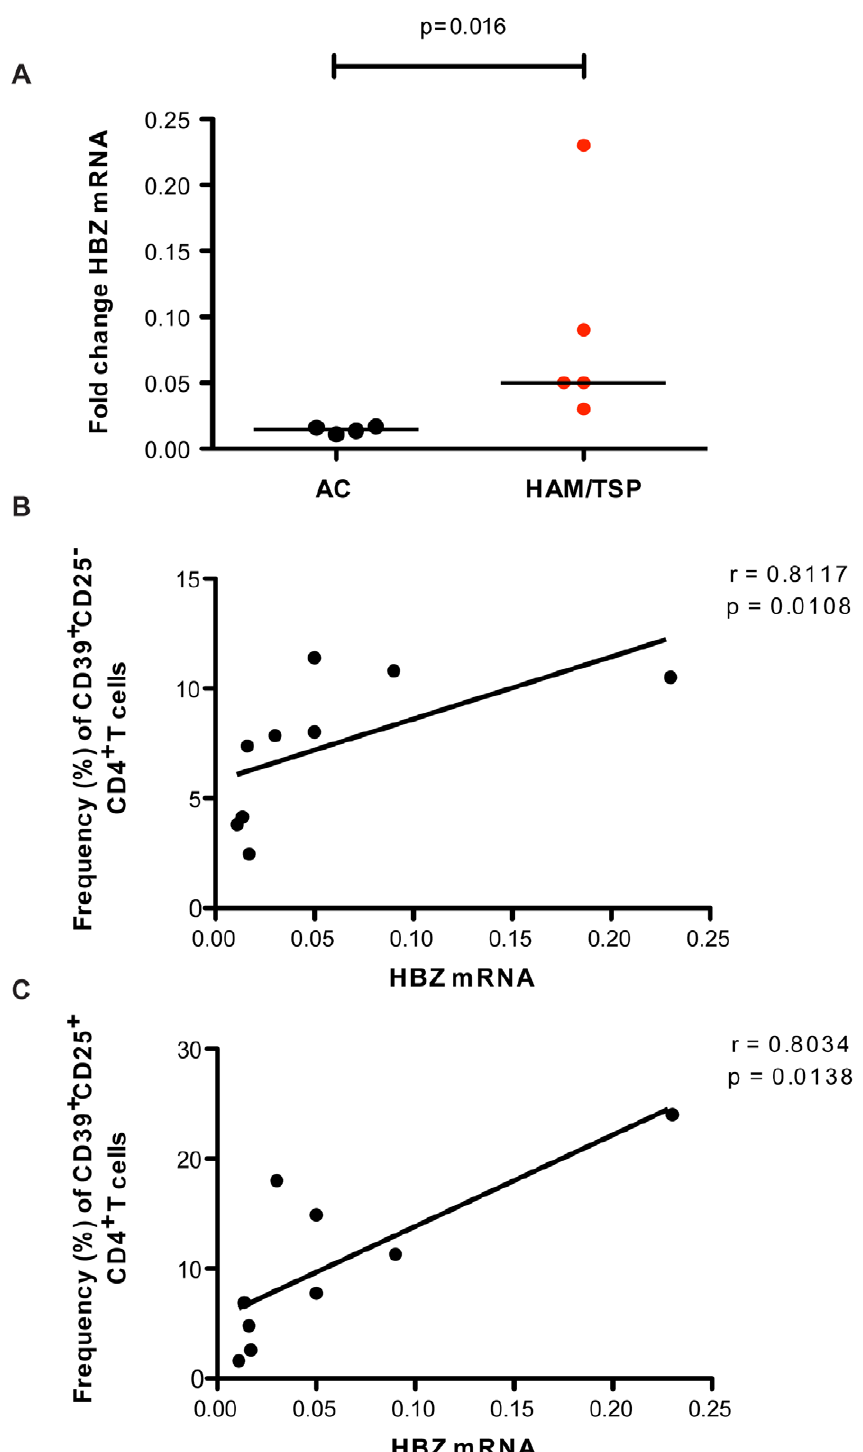
Figure 8. Relative HBZ mRNA expression. Expression was calculated as 2 2 DD Ct using the mean of b -actin as housekeeping controls. The statistical difference was deemed significant using a Mann-Whitney U test analysis if p , 0.05. Horizontal bars denote median values. (A) Fold change of HBZ mRNA expression in PBMCs of 4 ACs and 5 HAM/TSP patients. (B) Positive correlation between HBZ mRNA levels and frequencies of CD39 + CD25 2 CD4 + T cells in HTLV-1-infected patients. (C) Positive correlation between HBZ mRNA level and frequency of CD39 + CD25 + CD4 + T cells in HTLV-1-infected patients.